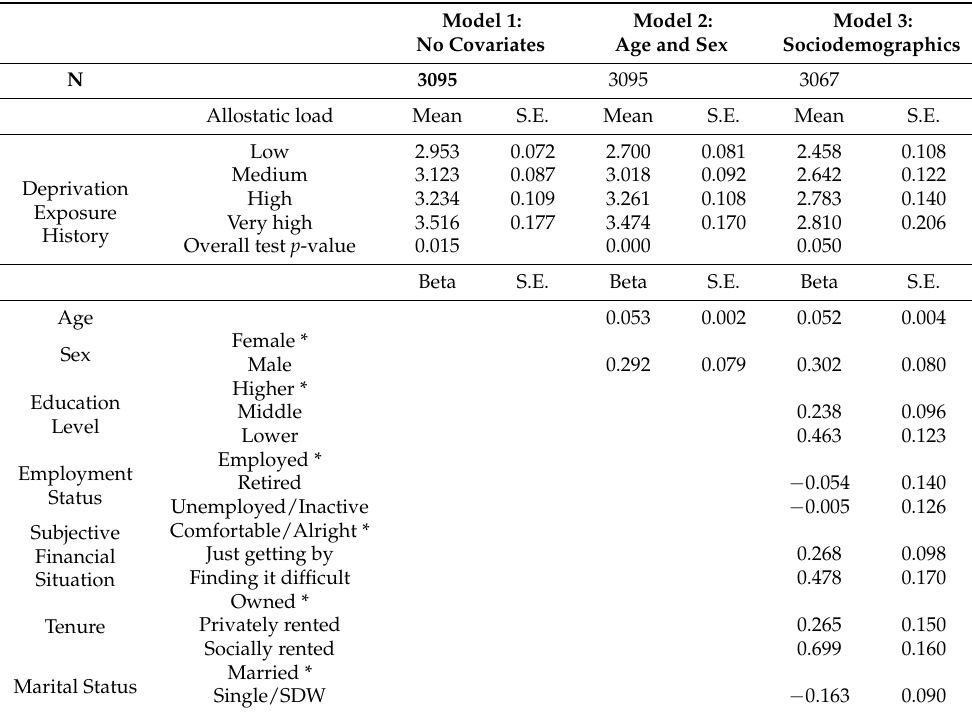
Figure 1. Mean predicted allostatic load score by deprivation history for each model. Table 4. Estimated allostatic load means by deprivation history and covariate coefficients predicting allostatic load.